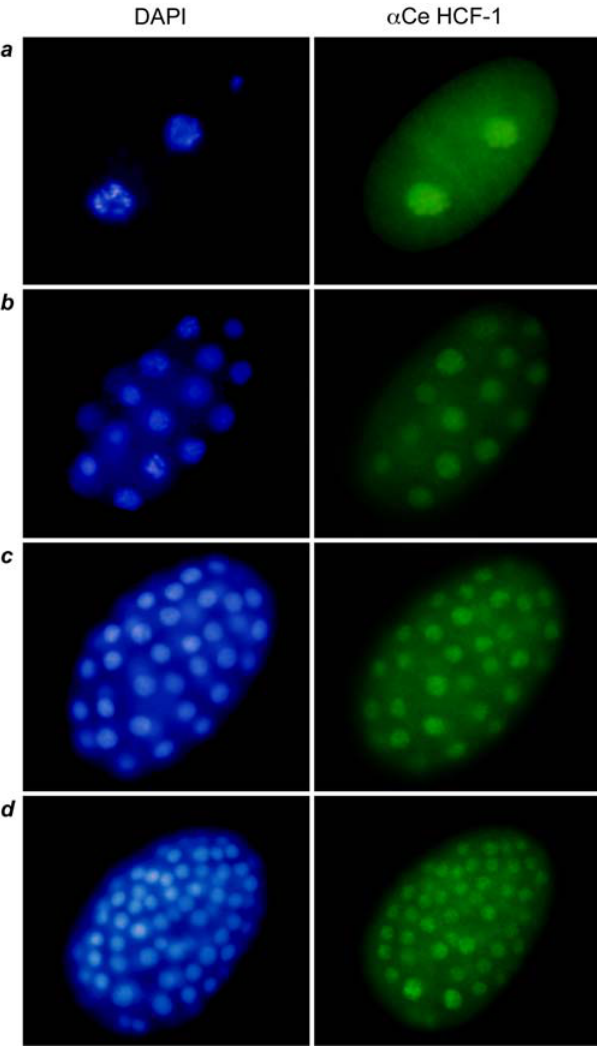
Figure 4. CeHCF-1 is a nuclear protein widely expressed in embryos. Immunofluorescence analysis of Ce HCF-1 expression in wild-type embryos at four progressive embryonic stages ( a – d ). Nuclei were visualized by DAPI staining (blue labeling, left). Ce HCF-1 (green labeling, right) was detected using the monoclonal a Ce HCF-1 antibody.